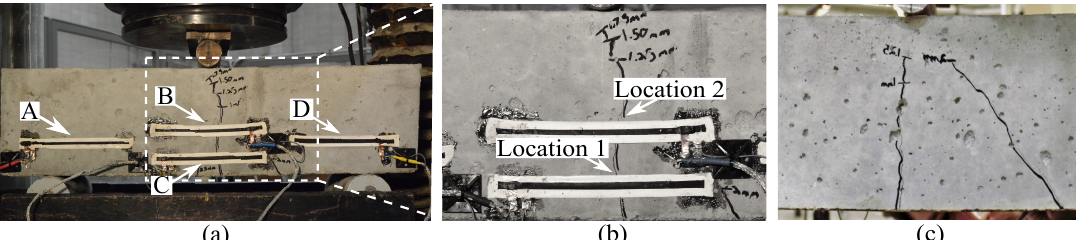
Figure 3. ( a ) Crack patterns on the small-scale reinforced concrete beam; ( b ) an enlarged view of the cracks on the front side of the specimen; and ( c ) an enlarged view of the cracks on the back side of the specimen showing a shear